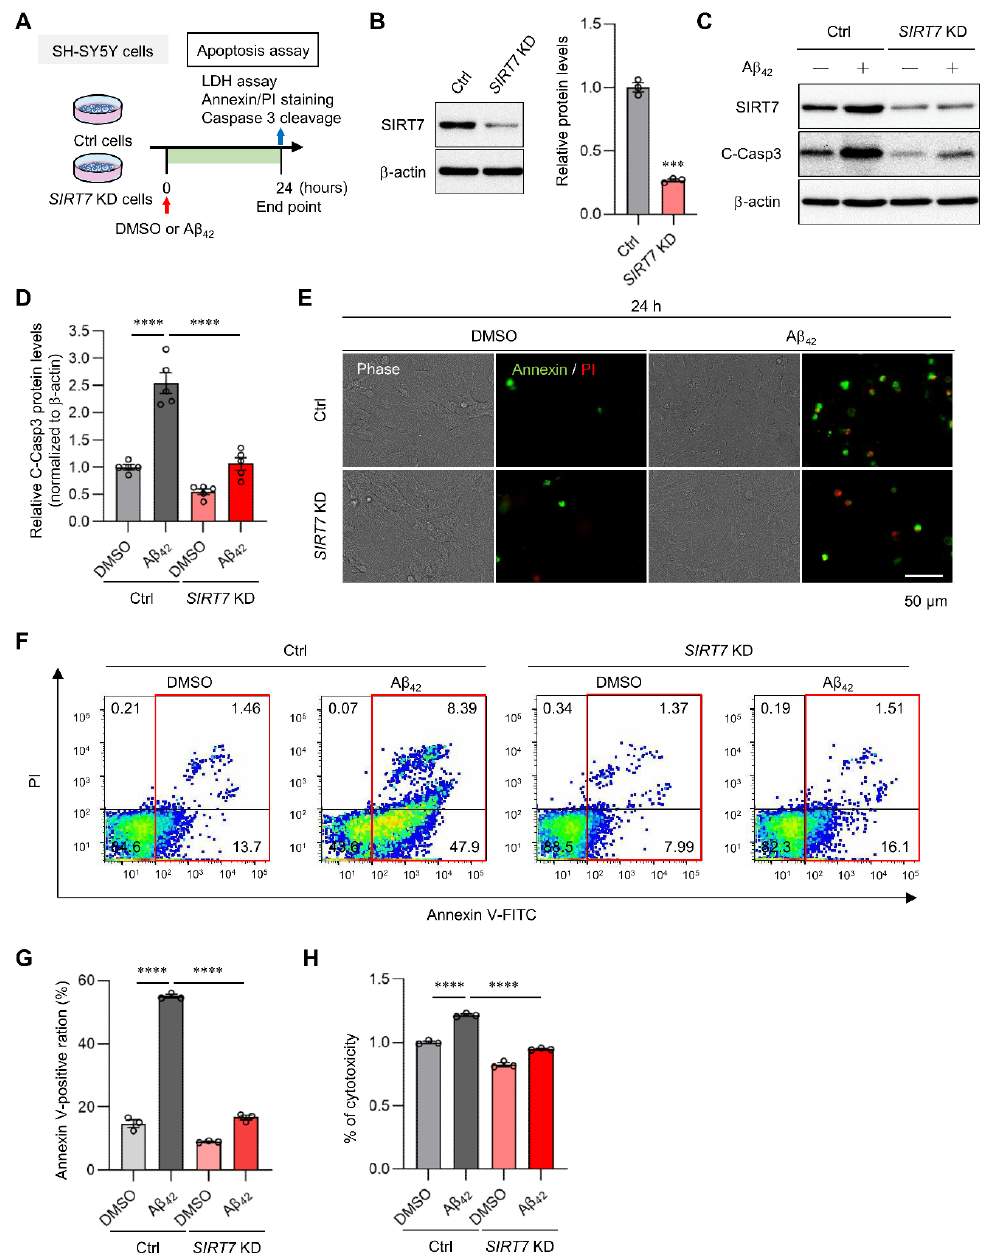
Figure 2. SIRT7 KD improves A β -induced apoptosis. ( A ) Experimental scheme for analyzing A β 42 - induced apoptosis in SIRT7 KD SH-SY5Y cells. ( B ) SIRT7 KD efficiency was confirmed by Western blot analysis when SH-SY5Y cells were transfected with SIRT7 siRNA for 48 h. ( C ) After SH-SY5Y cells had been transfected with control and SIRT7 siRNA for 48 h, cells were treated with 5 µ M A β 42 for 24 h. Western blot analysis of cleaved caspase 3 was performed. ( D ) The value of cleaved caspase 3 was normalized to that of β -actin. ( E ) Representative microscopy images of fluorescent annexin V (green)- and PI (red)-stained cells are shown for cells treated in the same condition as that in Figure 2A. Scale bar, 50 µ m. ( F ) Flow cytometry analysis was performed on cells treated in the same condition as that in Figure 2A. Representative flow cytometry plots using annexin V-FITC/PI staining for apoptosis. ( G ) Percentage of total annexin V-positive cells was calculated. ( H ) Cell death was evaluated by an LDH activity assay on cells treated in the same condition as in Figure 2A. All data are shown as the mean ± SEM. Statistical significance was determined by either Student’s t -test or two-way ANOVA with Tukey’s post hoc test. *** p < 0.001; **** p <